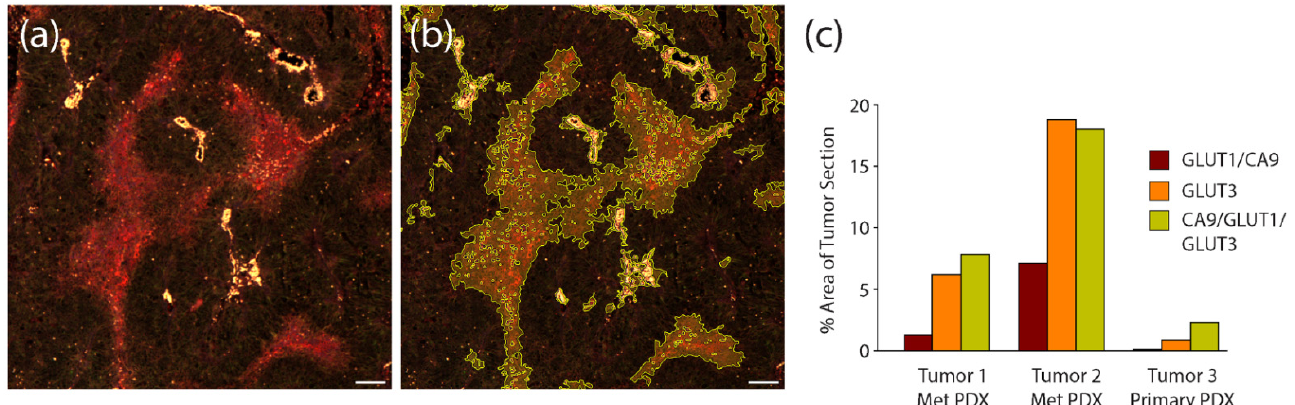
Figure 8. Compared to hypoxia biomarkers GLUT1 and CA9, GLUT3 labels larger areas within PDX tumor sections. ( a ) Patient-derived xenograft (PDX) from a primary prostate tumor immunostained with the triple anti-CA9, GLUT1, and GLUT3 antibody cocktail. Scale, 100 μ m. ( b ) Same image as in ( a ) with binary mask to outline regions of the triple stain. ( c ) Graph shows measurements of total area of each stain within 3 different PDX prostate tumors. Three sequential sections were obtained from each tumor, stained for either CA9/GLUT1, GLUT3, or the triple stain CA9/GLUT1/GLUT3, and imaged. Total area of staining was quantified by masking regions of high intensity staining using Nikon Elements image analysis software. Note, in the metastatic prostate PDX tumor samples, the vast majority of the signal observed in the triple stain is due to the GLUT3 stain. However, in the primary prostate PDX, GLUT3 staining alone is not as effective at revealing putative hypoxic regions compared to the triple stain.